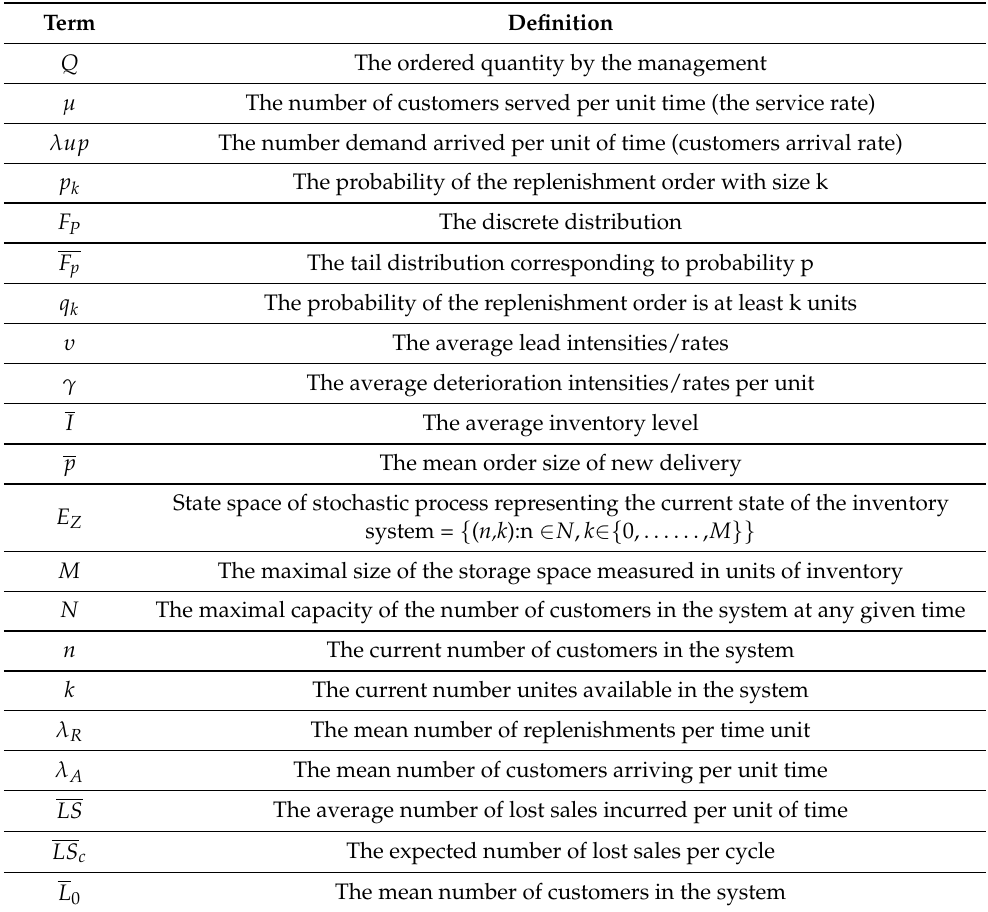
Table 1. The list of variables introduced during the building of the balance equations and the investigated performance